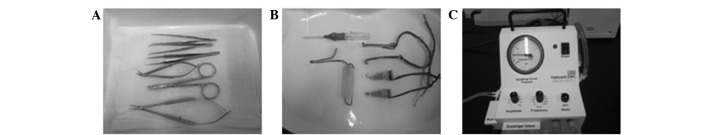
Surgical instruments and equipment. (A) Surgical instruments; (B) self-prepared surgical equipment; (C) small animal ventilator.